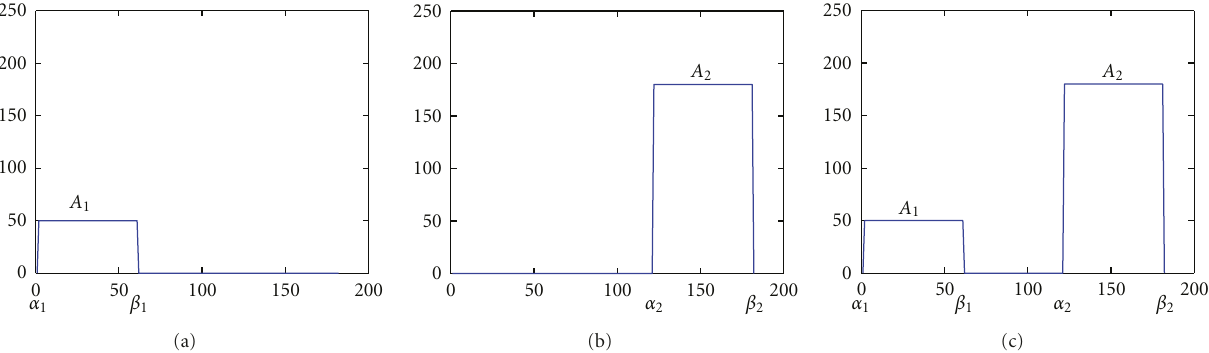
Figure 2: (a) The front of signal of Figure 1(b), (b) the back of signal of Figure 1(b), and (c) the signal is superimposed by (a) and (